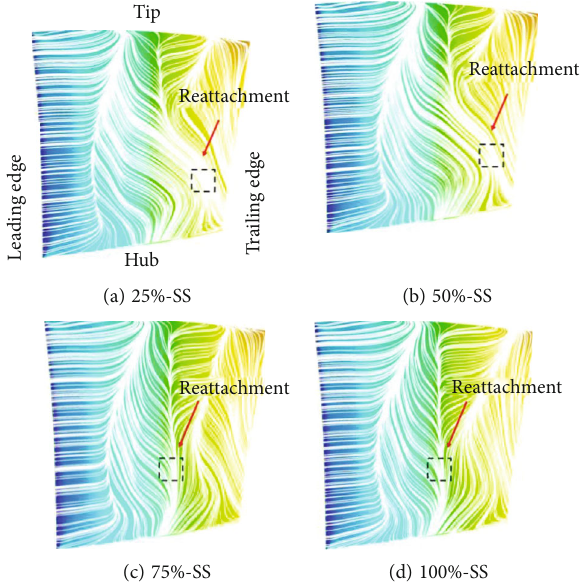
Figure 23: Limiting streamline on the rotor suction surface for the di ff erent roughness locations at k + = 46 : 6